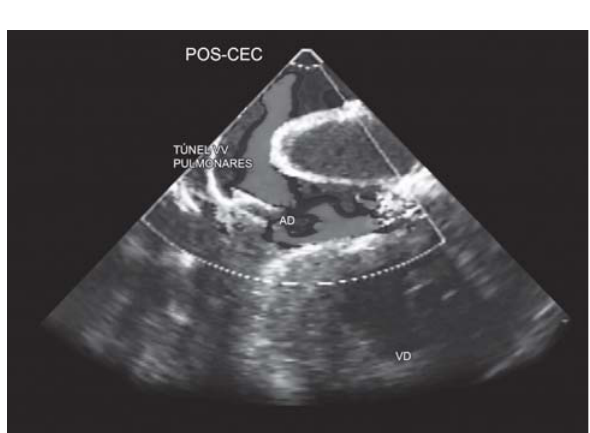
Fig. 3 - Ecocardiograma transesofágico com Doppler, em corte no no nível do átrio direito e o túnel das veias pulmonares após correção da estenose. POS-CEC: pós-circulação extracorpórea. VV: veias. AD: átrio direito. VD: ventrículo